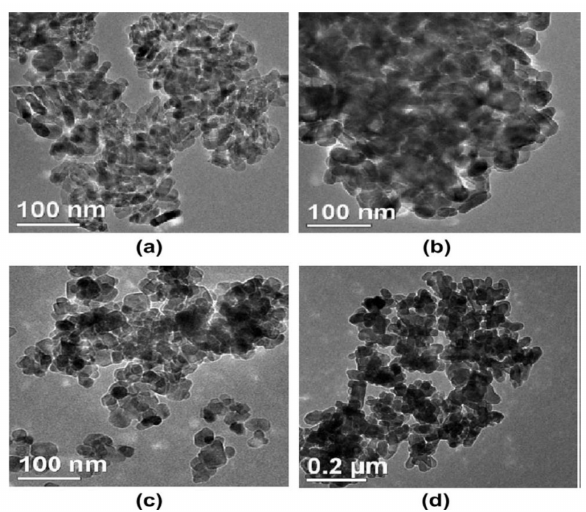
Figure 15. TEM image of the TiO 2 nanofluids with dispersed nanoparticles of average